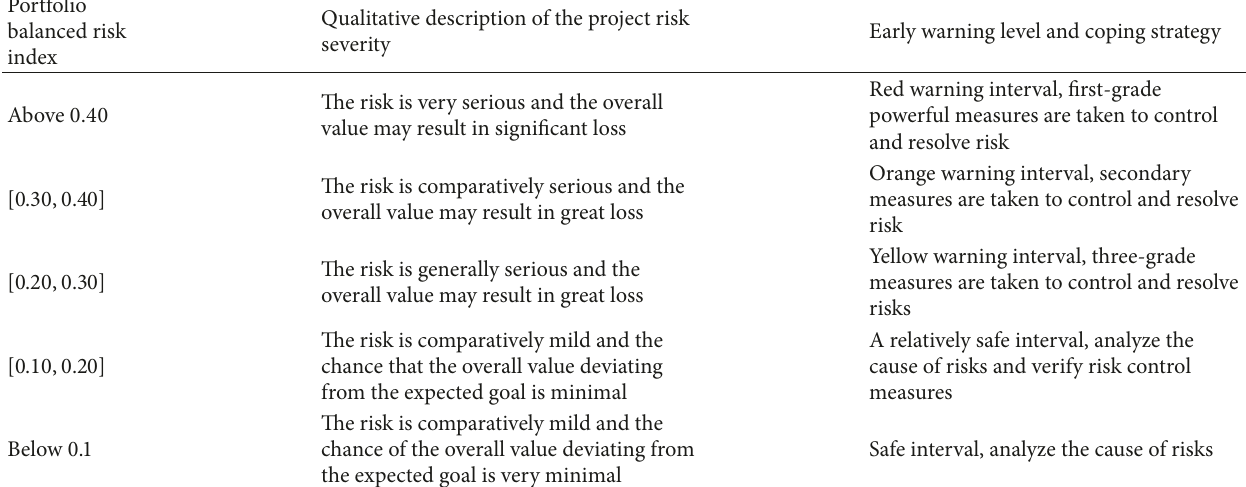
Table 13: Early warning level of project risk